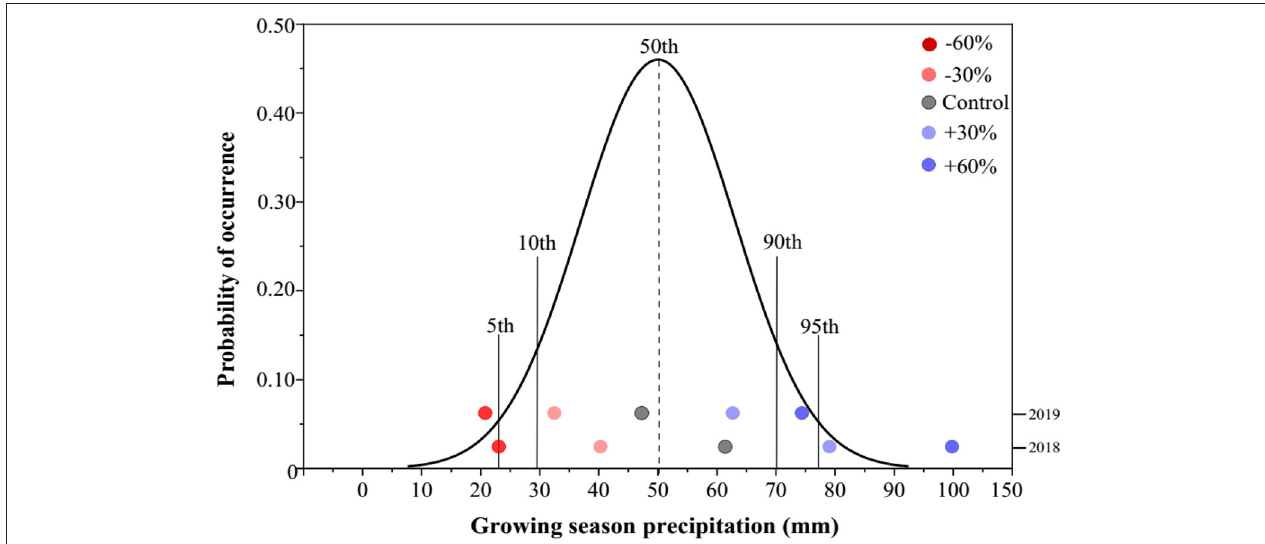
FIGURE 1 | Probability distribution of annual precipitation in the study area during the plant growing season over the past 100 years. The precipitation treatments include five levels, namely, − 60%, − 30%, Control, + 30%, and + 60% precipitation relative to the ambient level.